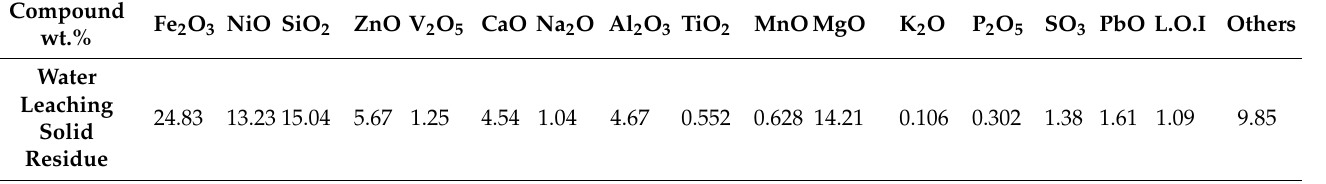
Table 1. Overall chemical analysis of water leaching solid residue (WLSR).